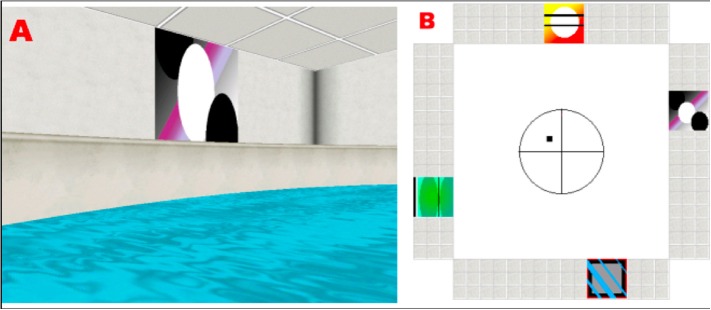
(A) Example of a visual cue as seen from the subject's perspective, while navigating in the platform. (B) Floor plan of the virtual room, indicating the position of the cues and the platform (black square).